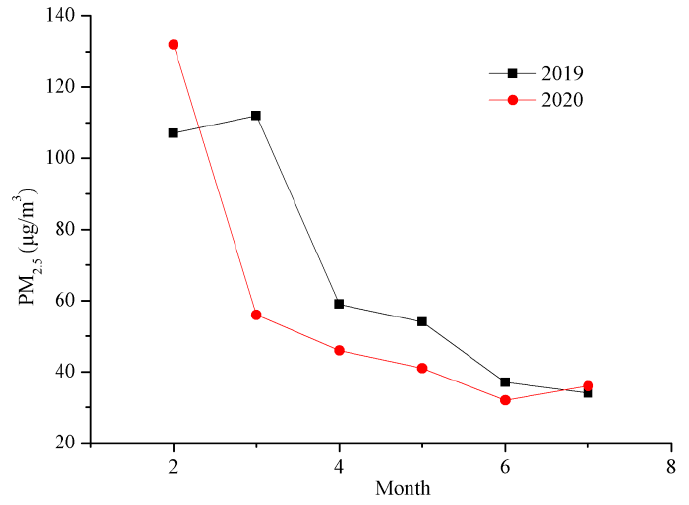
Figure 6. Comparison of the monthly average PM 2.5 concentration in Liaocheng City from January to June 2019 and 2020. The cycles of monthly PM 2.5 concentration in Liaocheng were calculated using wavelet analysis (Figure 7). The wavelet variance can reflect the distribution of wave energy of a time series. It can be used to determine the main periods of monthly PM 2.5 concentration.